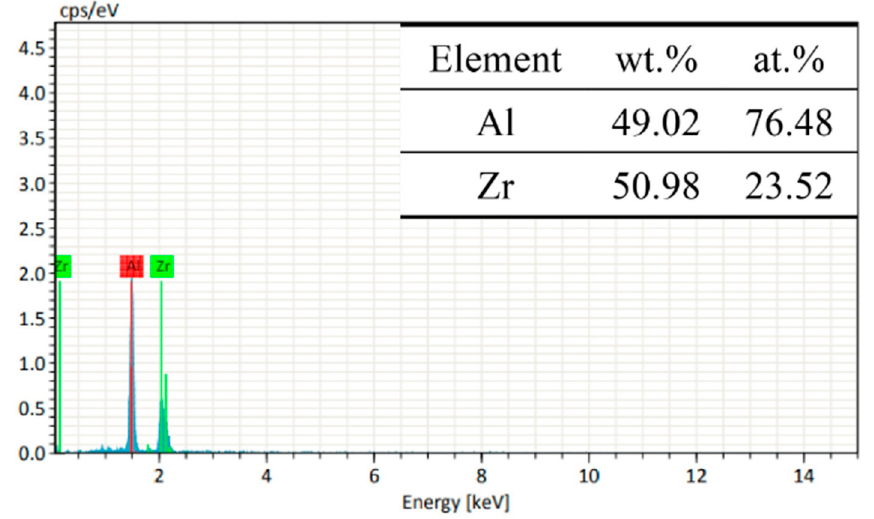
Figure 2. EDS spectrum of the white second phase.